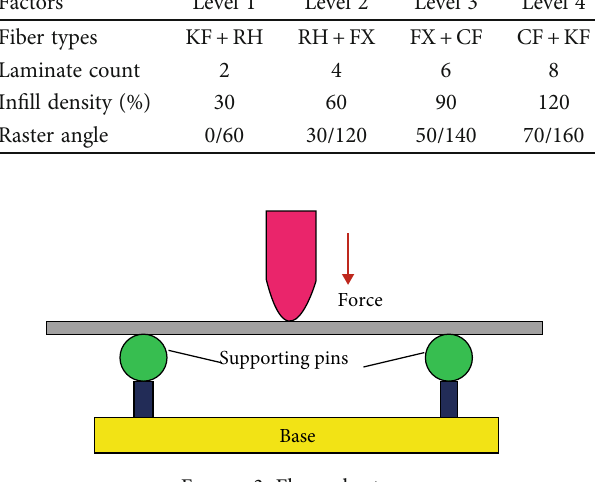
Figure 3: Flexural setup.